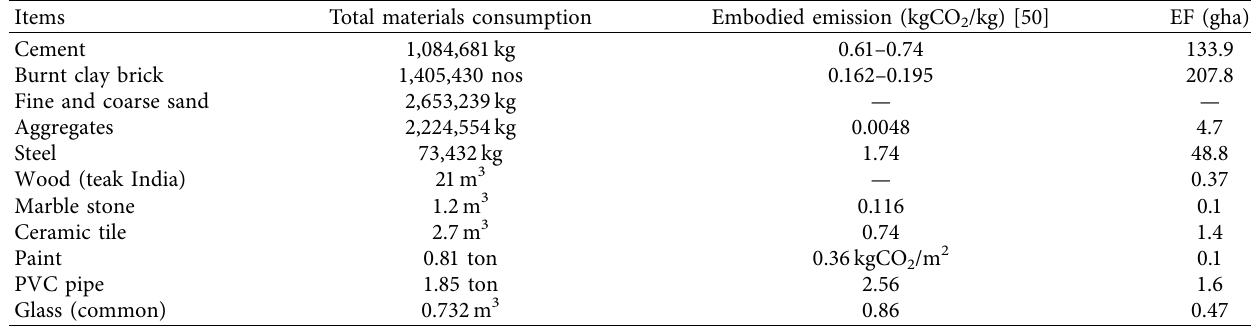
Table 8: Details of materials consumed in the case study building.